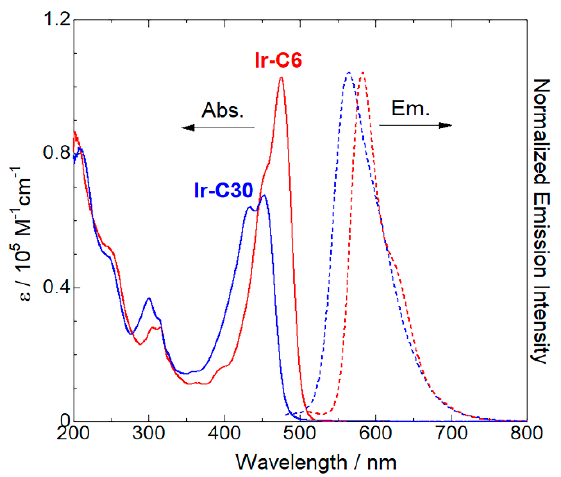
Figure 3. Ultraviolet-visible absorption (solid lines) and luminescence (dotted lines; λ ex = 450